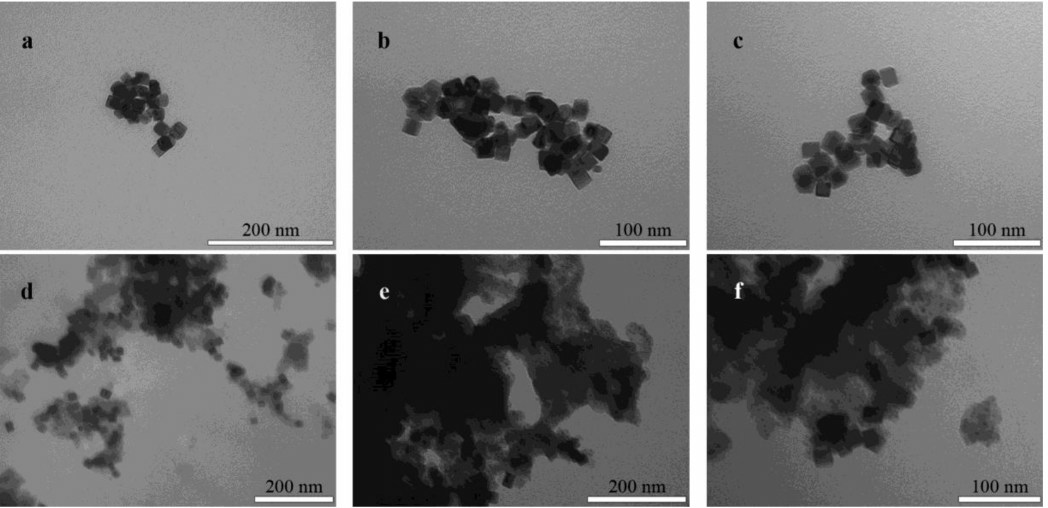
Figure 1. Representative TEM micrographs of Pd nanocubes ( a – c ) and Pd@HKUST-1 ( d – f